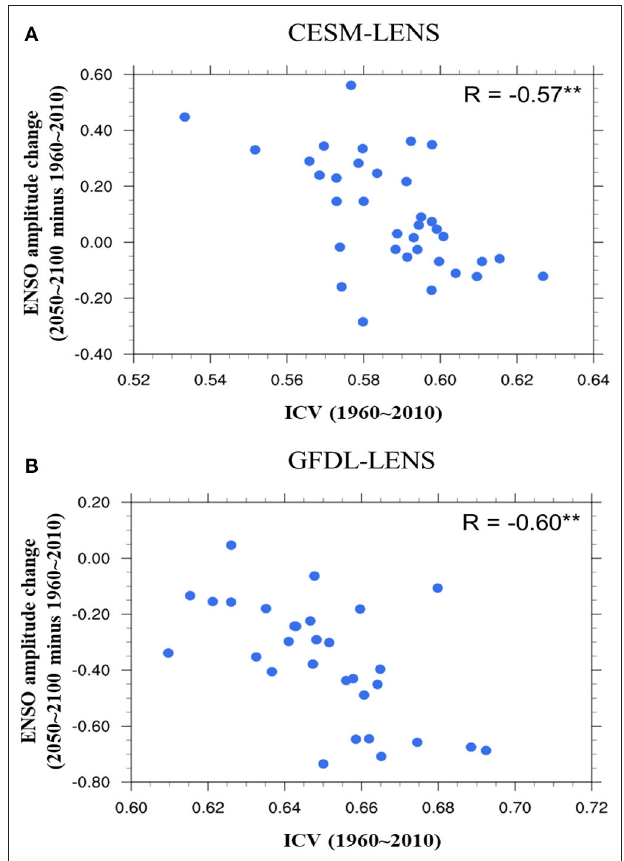
FIGURE 6 | ICV in the present climate vs. ENSO amplitude change from the present climate (1960–2010) to the future climate (2050–2100) in CESM-LENS (A) and GFDL-LENS (B) simulations. Unit is ◦